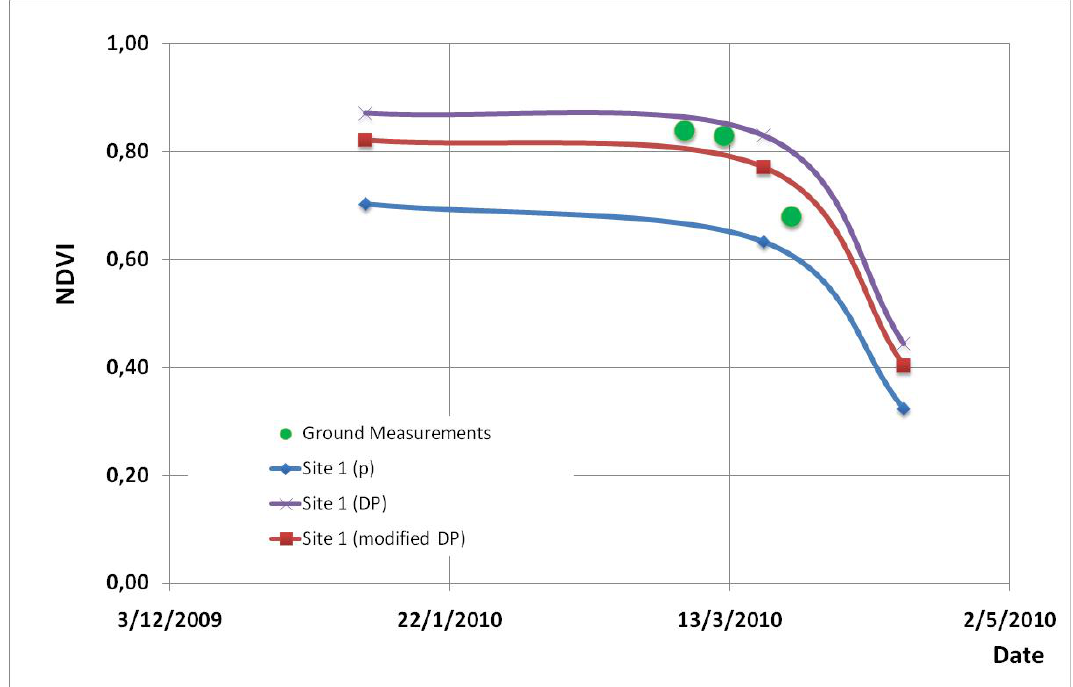
Figure 8. Comparison of NDVI values derived from satellite images (before and after atmospheric correction) and ground spectroradiometric measurements for Site